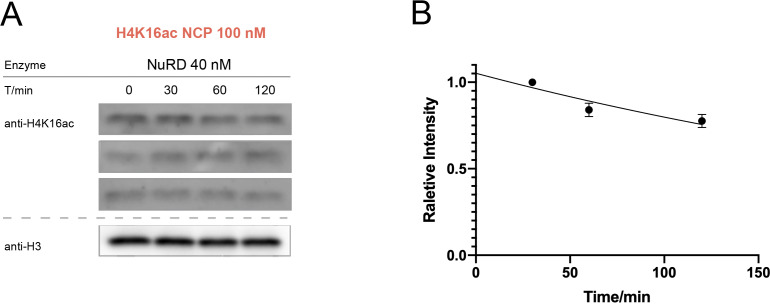
NuRD activity assay over H4K16ac nucleosome.(A) H4K16ac nucleosome (n = 3 for nucleosome assay), and (B) Curve fitting for the nucleosome kinetics with 40 nM NuRD.